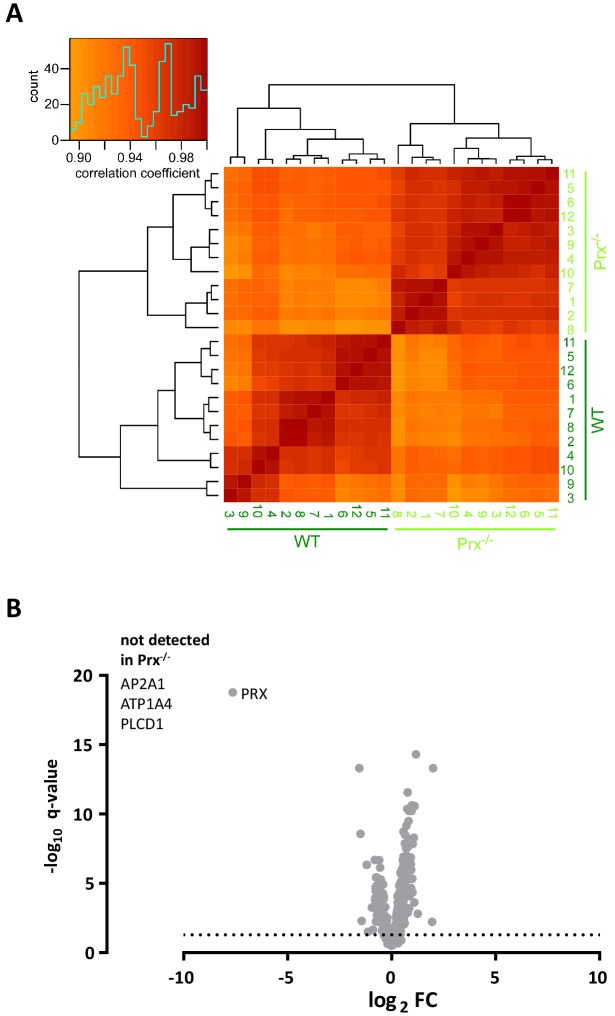
Clustered heatmap of Pearson’s correlation coefficients for protein abundance comparing genotypes.(A) The heatmap compares the log2 transformed ppm protein abundance values from the DRE-UDMSE runs to assess peripheral myelin purified from wild type and Prx-/- mice. The inset shows the color key and the histogram for the values of the correlation coefficients. Note that the runs cluster with a high overall correlation (>0.85) into two conditions defined by the genotype, in agreement with the experimental design. (B) Volcano plot representing genotype-dependent quantitative myelin proteome analysis. Data points represent quantified proteins in Prx-/- compared to wild-type myelin plotted as the log2-transformed fold-change (FC) on the x-axis against the -log10-transformed q-value on the y-axis. Note the different axis scale compared to Figure 5D. Stippled line marks a -log10-transformed q-value of 1.301, reflecting a q-value of 0.05 as significance threshold. Highlighted is the datapoint for PRX to illustrate that only trace amounts of PRX were detected when assessing Prx-/- myelin. ATP2A1, ATP1A4 and PLCD1 were not detected in Prx-/- myelin.